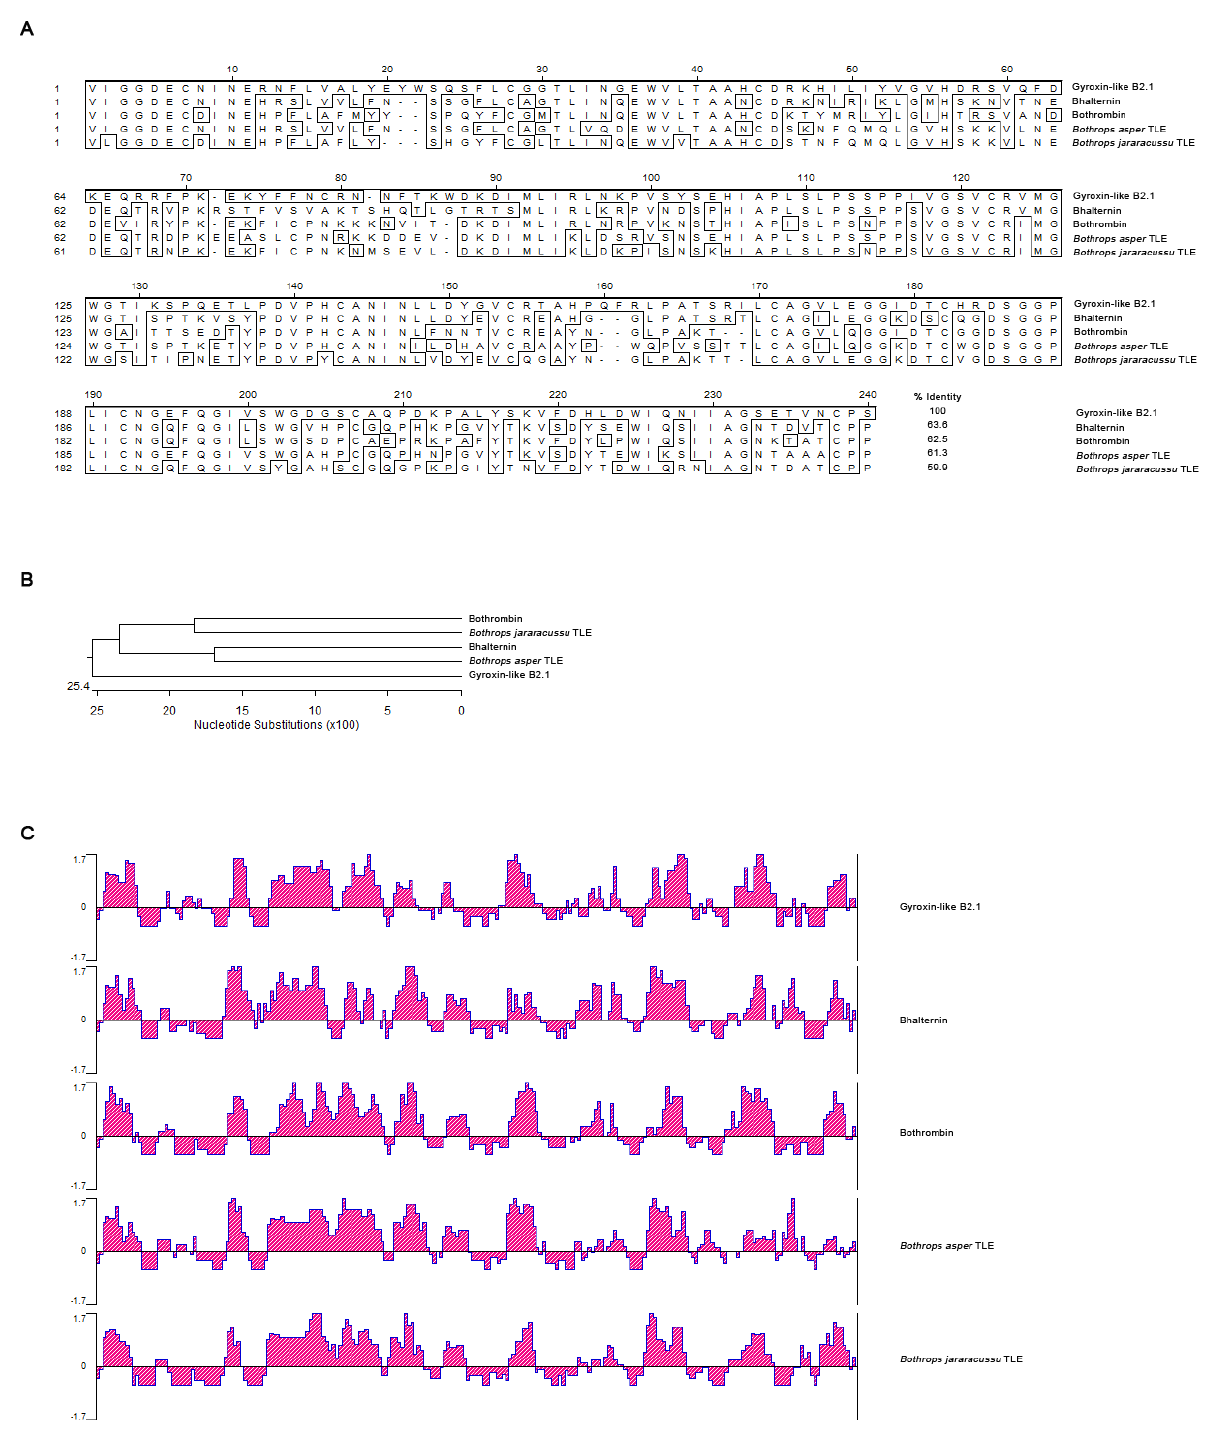
Figure 5. ( A ) Alignment of the amino acid sequence of several bothropic TLEs with gyroxin-like B2.1 from Crotalus durissus terrificus . ( B ) Phylogenetic tree constructed with four bothropic thrombin-like enzymes and a crotalic thrombin-like enzyme (gyroxin-like B2.1). ( C ) Antigenic profiles calculated with Jameson and Wolf (19) algorithm from the linear amino acid sequences of bothropic and crotalic